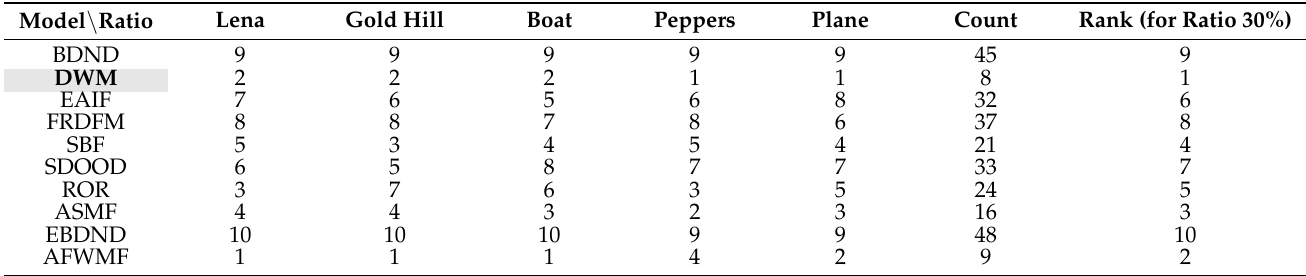
Table 7. The ranking of the 10 filter models according to the three experts’ average evaluations at 30% noise density for the five experimental images.